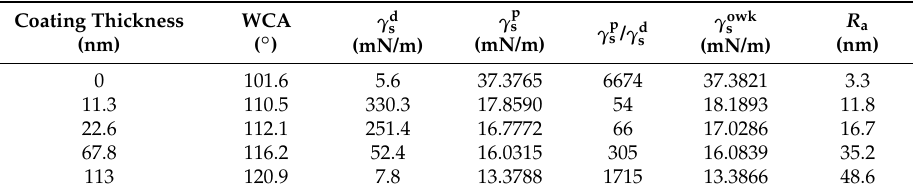
Table 1. Surface character of the fluorocarbon (FC) coating.